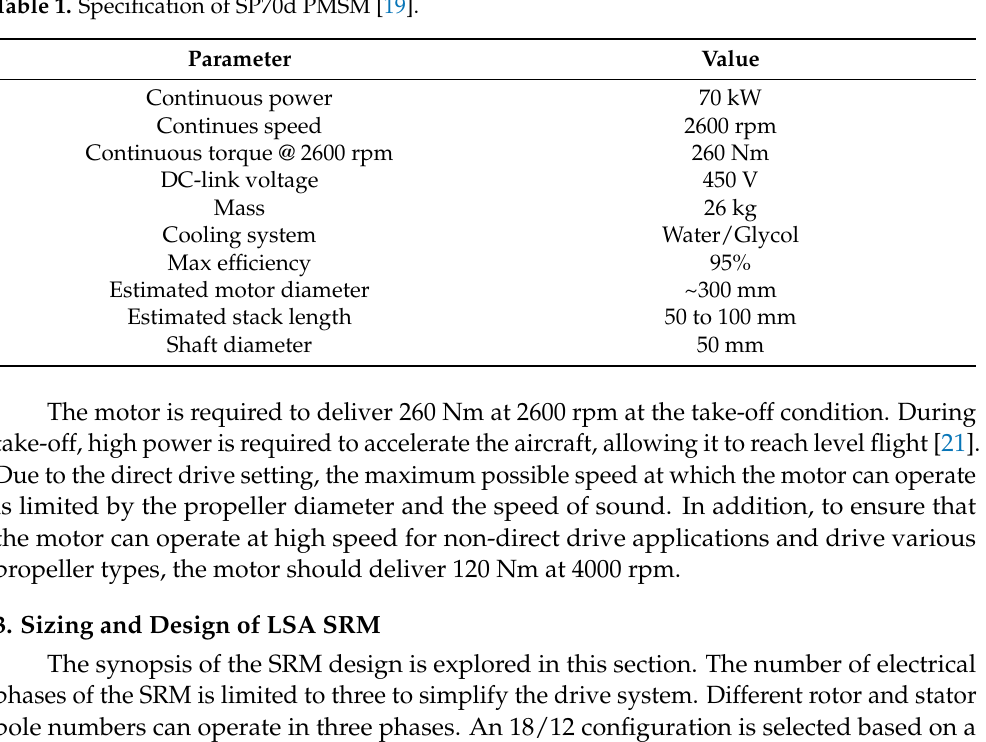
Electrical angle Electrical angle Electrical angle Figure 2. Comparison of static torque production with HIPERCO ® 50 and HIPERCO ® 50A for the dimensional constraints and current density levels of LSA SRM: ( a ) J = 5 A/mm 2 , ( b ) J = 15 A/mm 2 , and ( c ) J = 25 A/mm 2 . 3.2. Electromagnetic Design with the Proposed Framework The authors proposed a multi-objective design framework in [23] for the design of a high power density SRM. A similar approach is employed in the design process of the LSA SRM. The design process is divided into two stages for control optimization and ge- ometry optimization. As illustrated in Figure 3, the first stage finds all the geometry com- binations with high static average torque. The geometry combinations are clustered and put through the second layer of the framework, the dynamic design stage. The objective of the dynamic design stage is to improve the average torque, and reduce radial force and torque ripple. The dynamic design consists of a loop involving control and geometry op- timization. The limited boundary of changes limits the variation of the optimum control parameters. After applying the dynamic design to all high-static-average-torque combi- nations, the best design is selected as the final design.